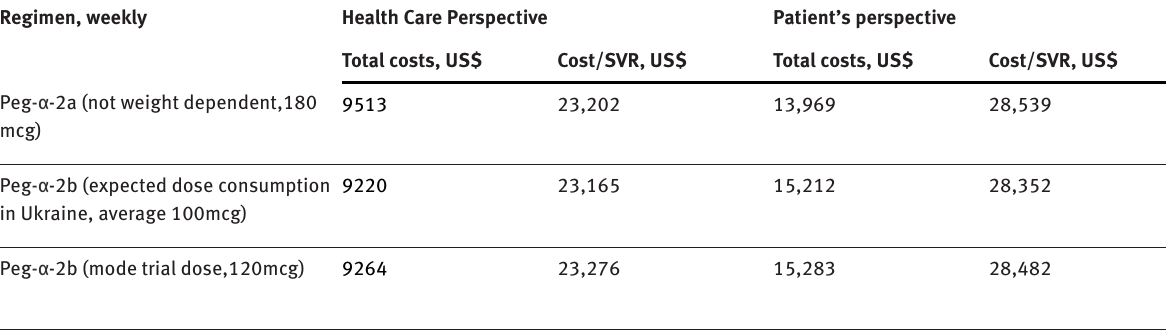
Table 3: Economic outcomes per patient infected with HCV genotype 1